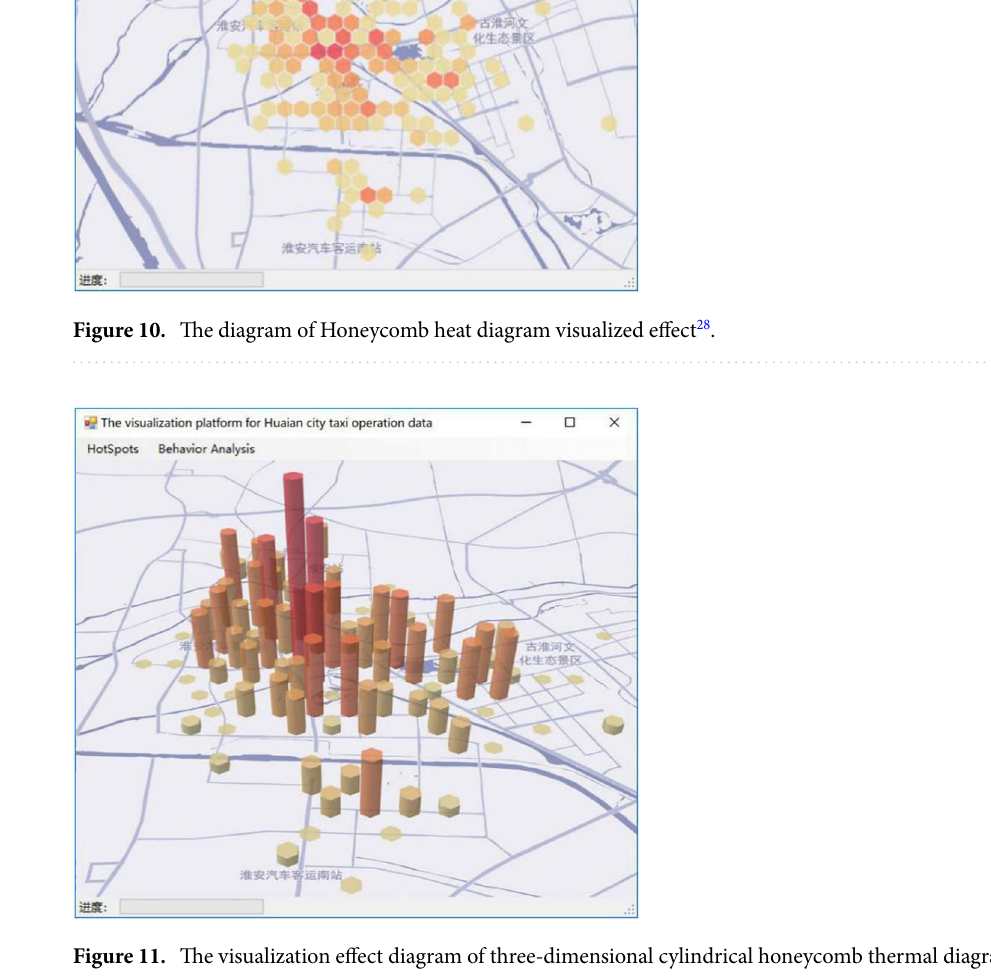
Figure 11. The visualization effect diagram of three-dimensional cylindrical honeycomb thermal diagram 28